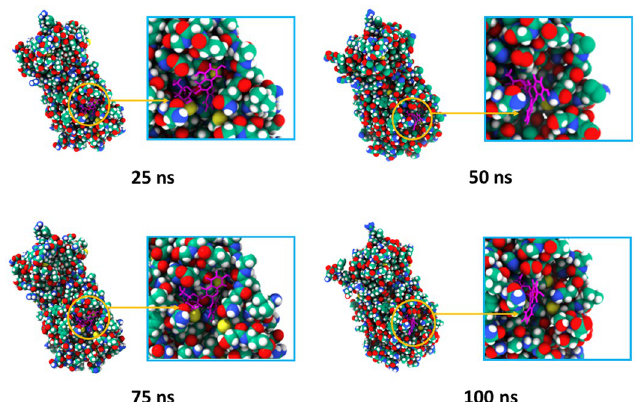
Fig 5. Surface view and binding pockets of the Pelargonidin-3-O-glucoside and Mpro complex, where snapshots at 25, 50, 75, and 100 ns were acquired.